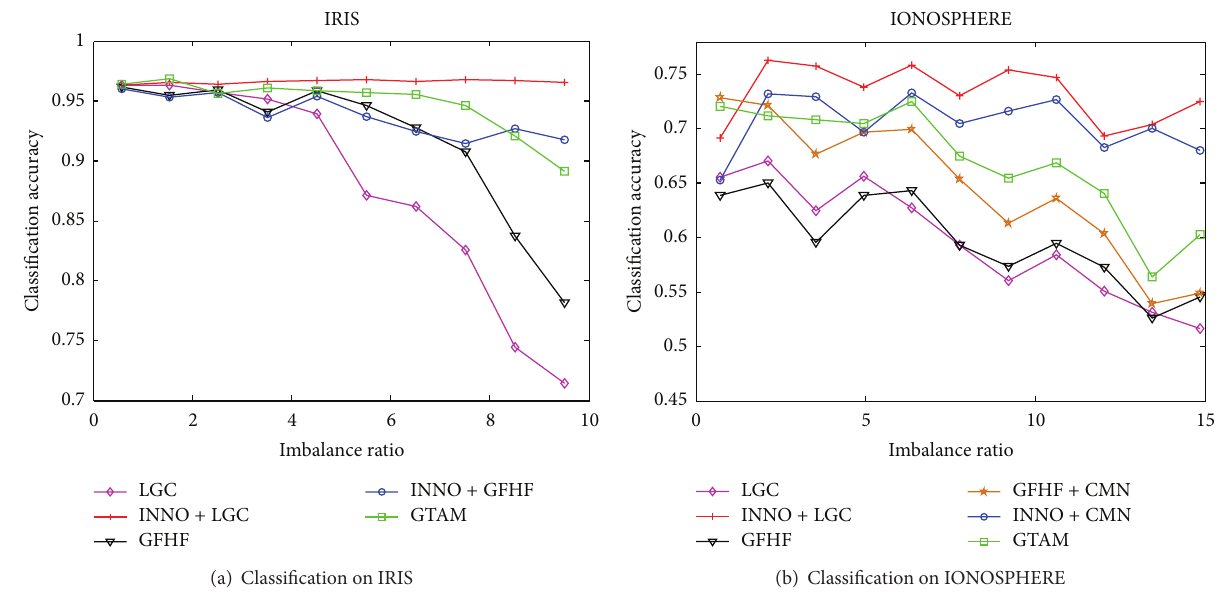
Figure 4: Influence of imbalanced ratio in labeled dataset to the classification accuracy.